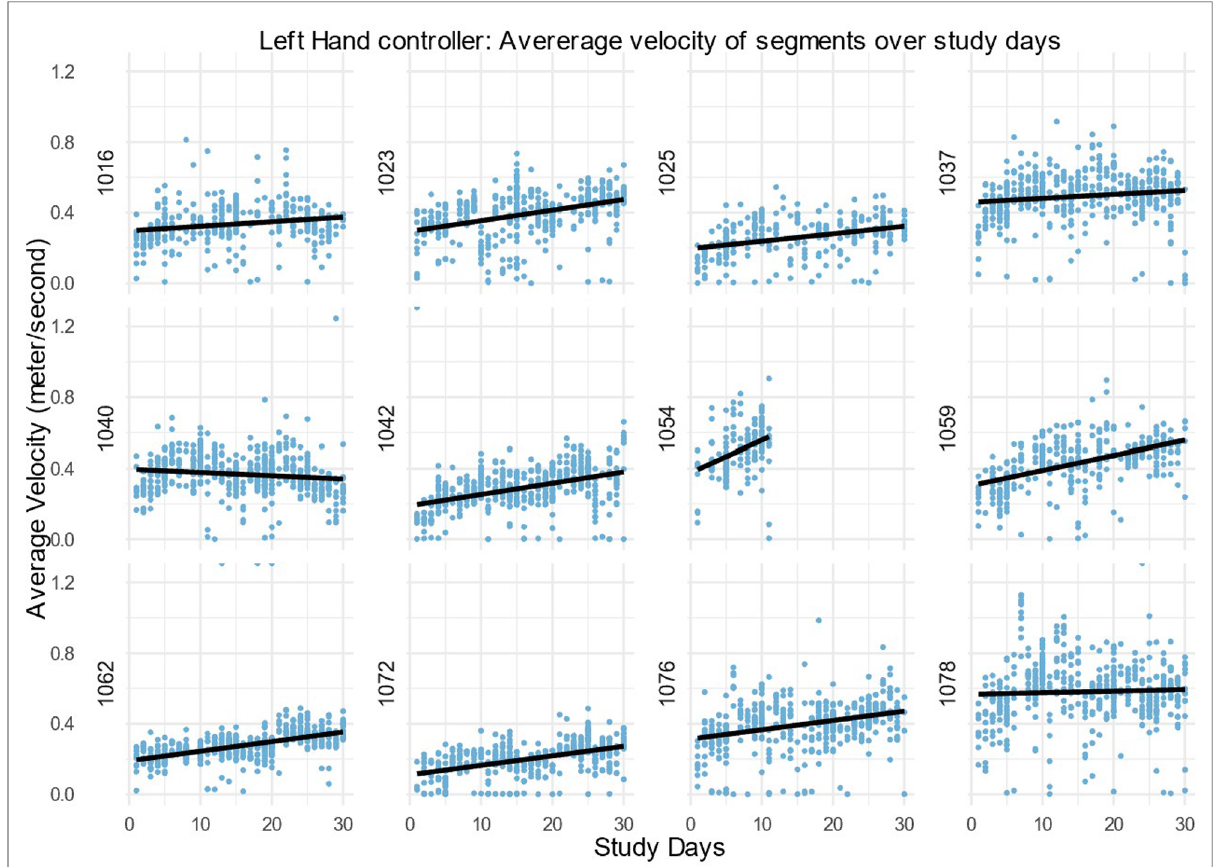
FIGURE 4 Average velocity in the left-hand controller of all action task segments within the 30 daily sessions (m/s) for all DTxP arm participants, with the regression line over the